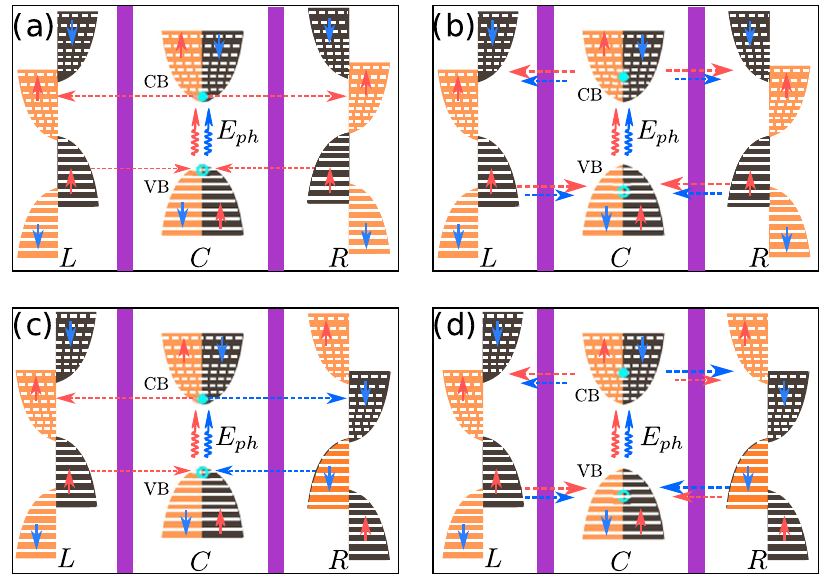
Fig. 6 Schematic plots of photocurrent generation in “ PP ” and “ PN ” con fi gurations. The schematic plot of spin photocurrent generation occurring at: a the photon energy slightly larger than the band gap and b the photon energy much larger than the band gap in “ PP ” con fi guration. The schematic plot of spin photocurrent generation occurring at: c the photon energy slightly larger than the band gap and d the photon energy much larger than the band gap in “ PN ” con fi guration.